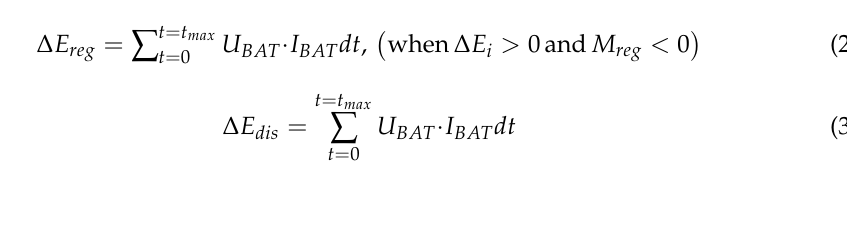
Figure 20. Comparison of the phase motion share during the RDC test in summer and winter